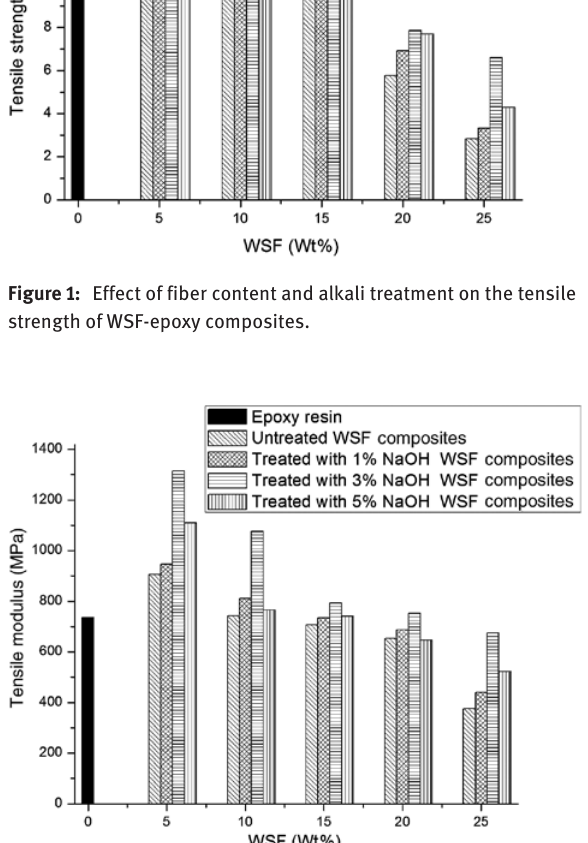
Figure 2: Effect of fiber content and alkali treatment on the tensile modulus of WSF-epoxy composites.